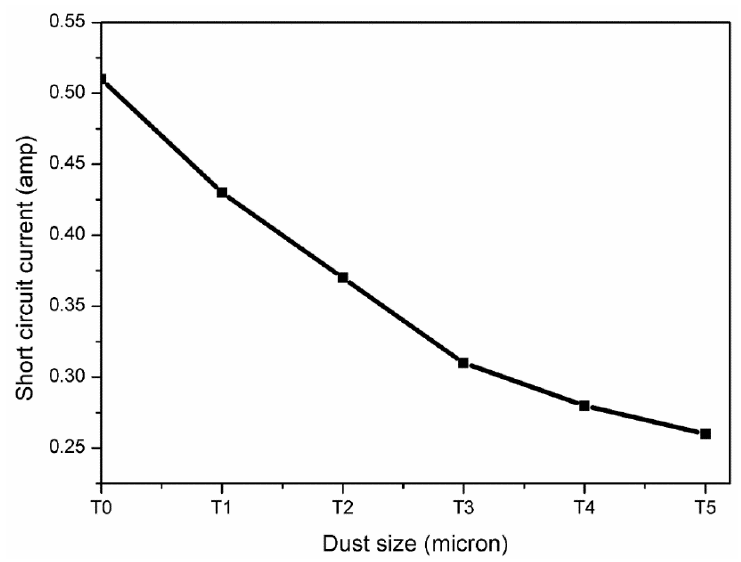
Figure 14. Short-circuit current relation with the deposition of different dust size .